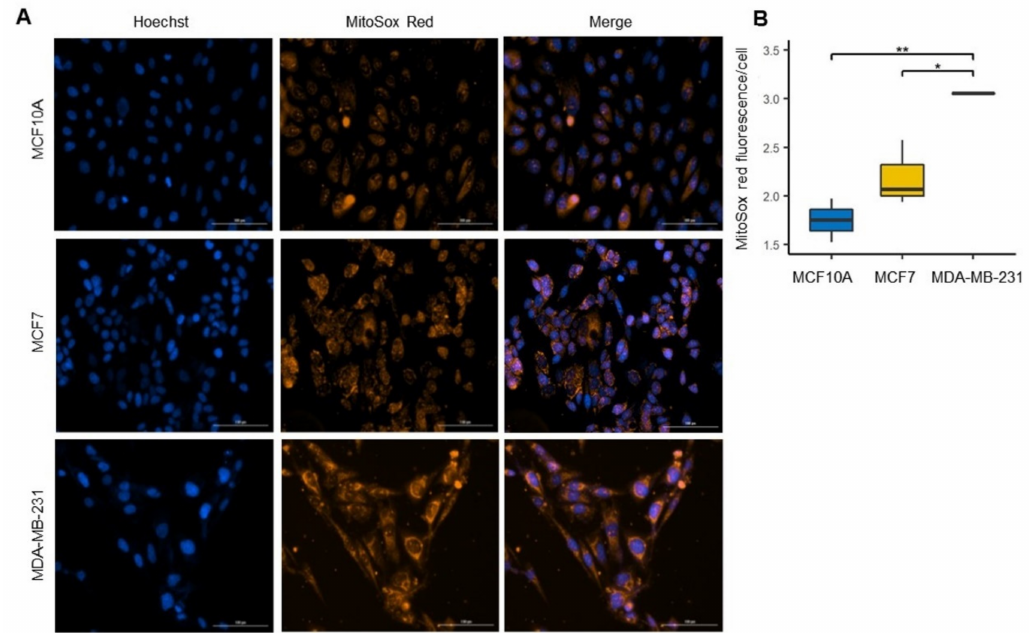
Figure 7. Increased levels of reactive oxygen species (ROS) in the MDA-MB-231 line. ( A ) Confocal microscopy images of mitochondrial ROS were stained by MitoSOX red (red) in MCF10A, MCF7 and MDA-MB-231 cell and total nuclei were stained with Hoechst (blue). ( B ) ROS production was quantified as MitoSOX red fluorescence intensity/cell ratio. Data were obtained from three biological replicates. The data are presented as mean ± SD of cells ( n = 153–200). * p < 0.05, ** p <